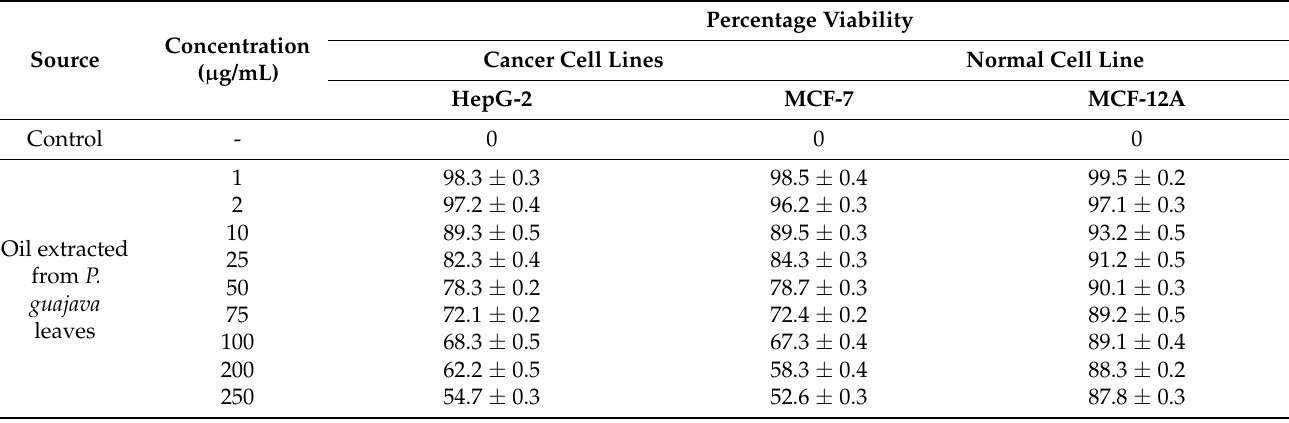
Table 2. Percentage viability of cancer cell lines of the oils extracted from P. guajava leaves at diffe- rent